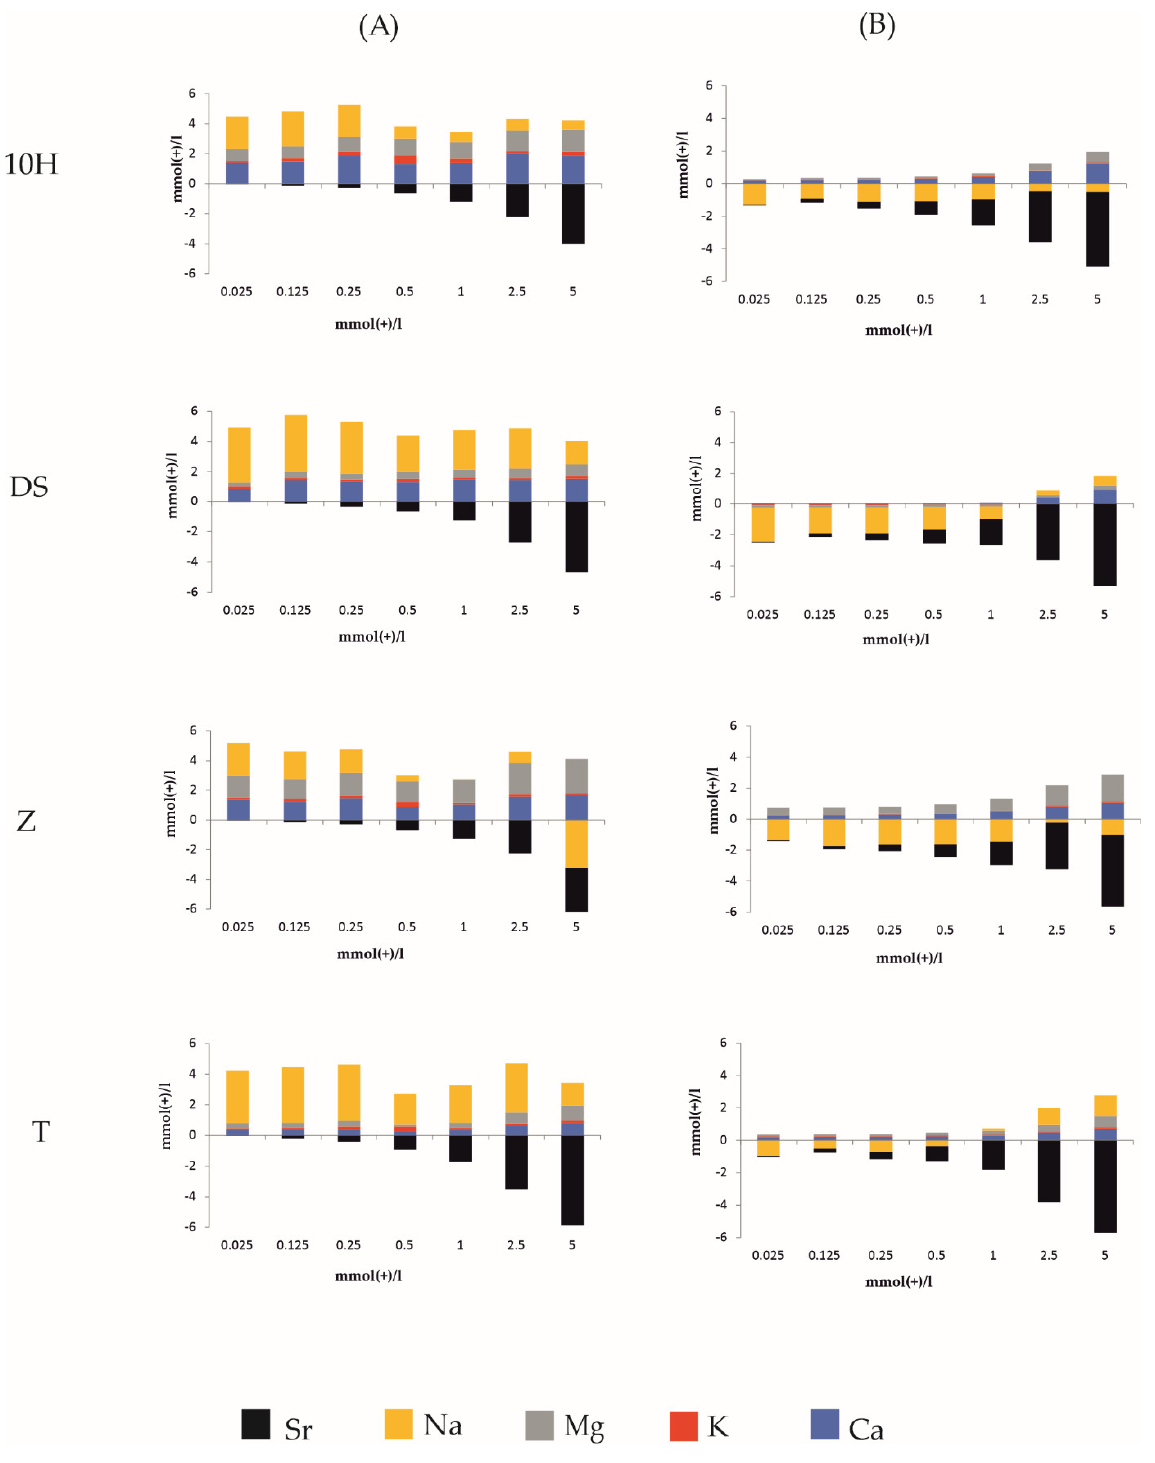
Figure 6. The number of cations released (+) and absorbed from the solution (−) depends on the initial concentration of the Sr(NO 3 ) 2 solution at pH 3 ( A ) and 10 ( B ). initial concentration of the Sr(NO 3 ) 2 solution at pH 3 ( A ) and 10 ( B